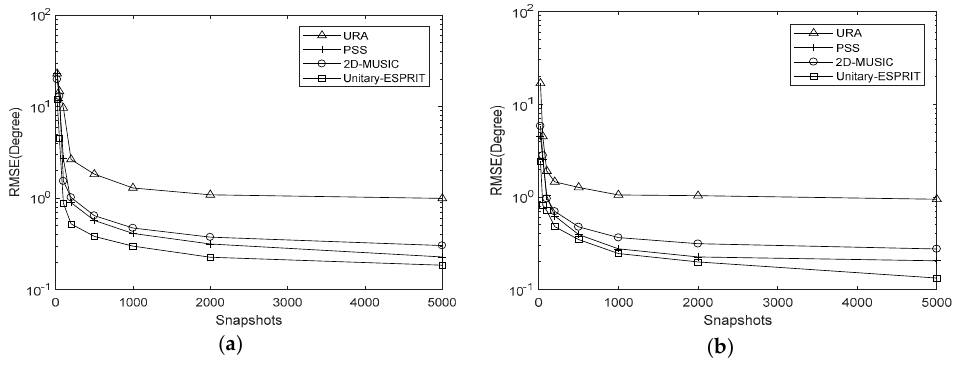
Figure 9. RMSE comparison under different SNRs with , . elevation. Simulation 3: RMSE comparison of the proposed algorithm using Unitary-ESPRIT and 2D-MUSIC,